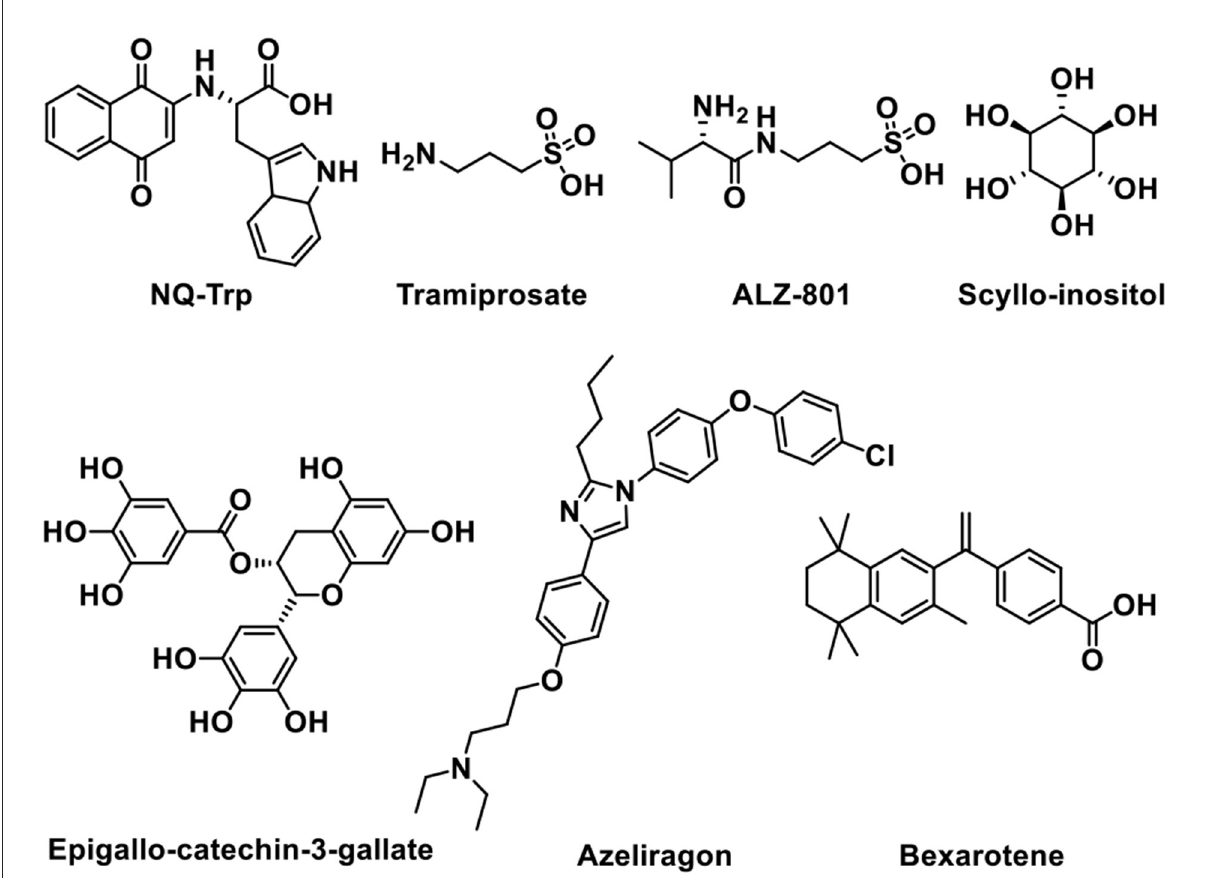
FIGURE8 Structures of molecules in preventing amyloid beta (A β ) aggregation.